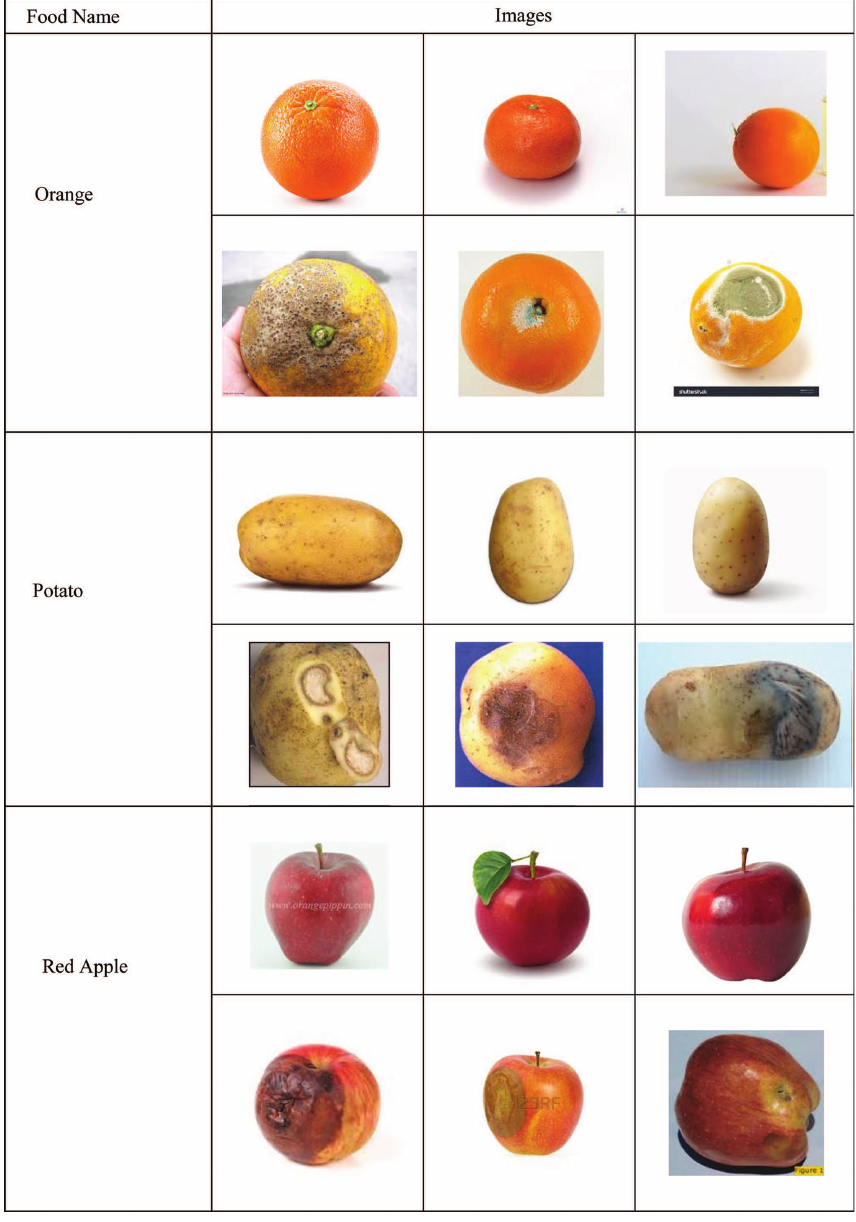
Figure 5: Input Database